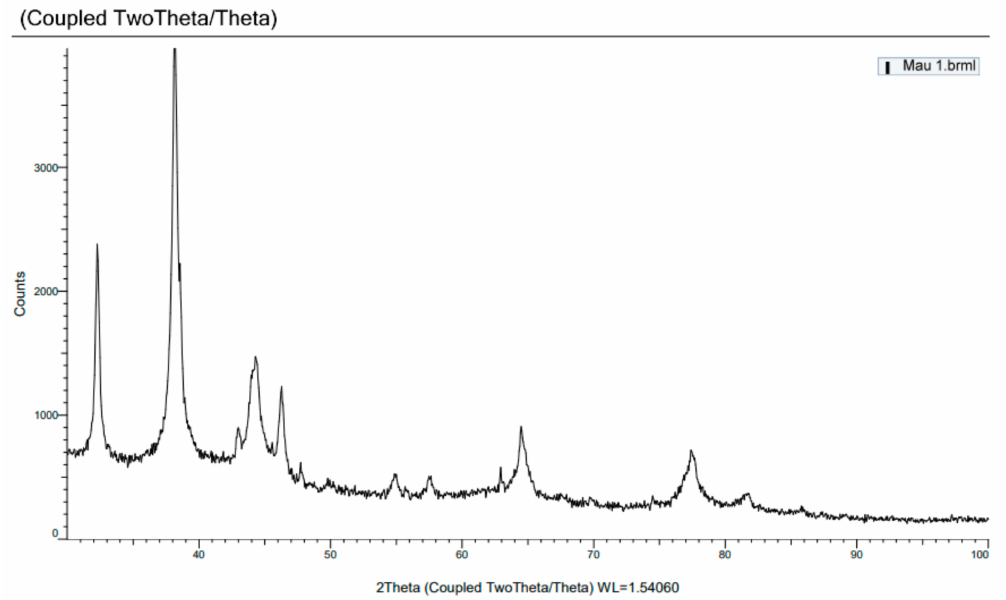
Figure 3. The XRD spectrum of the AgNPs produced in process B under incubation with 1 mM AgNO 3